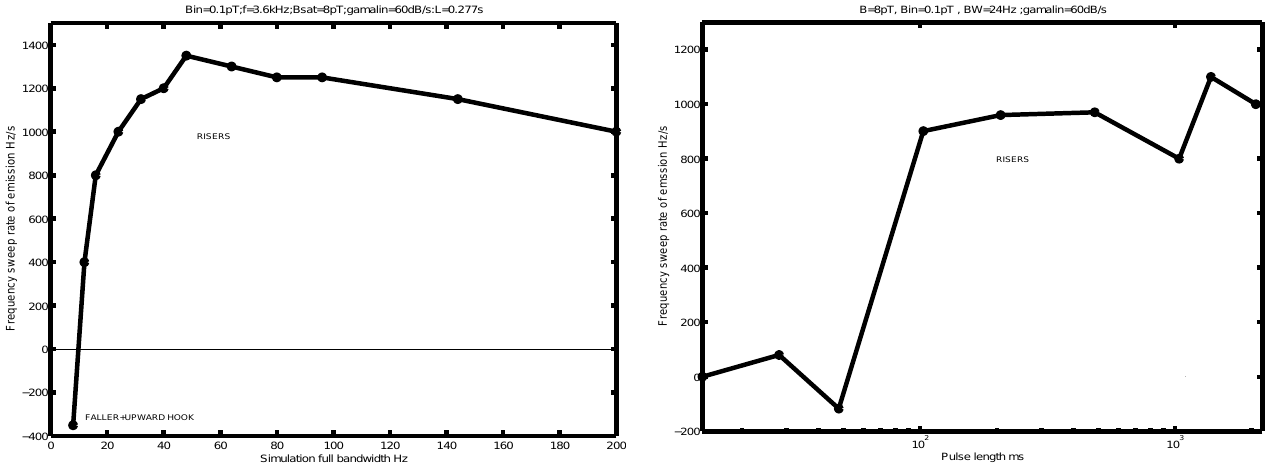
Fig. 13. Dependence of the emission sweep rate on simulation bandwidth. Above about one half the trapping frequency (25Hz) there is little dependence, as the triggered emission does not occupy the whole of the available bandwidth.